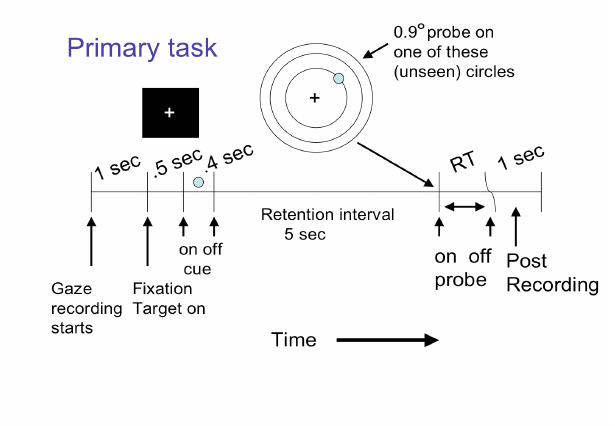
Figure 1. The structure of a trial. The wavy RT line represents the variable delay due to reaction time in the memory task. Tapping or dynamic visual noise occurred during the retention